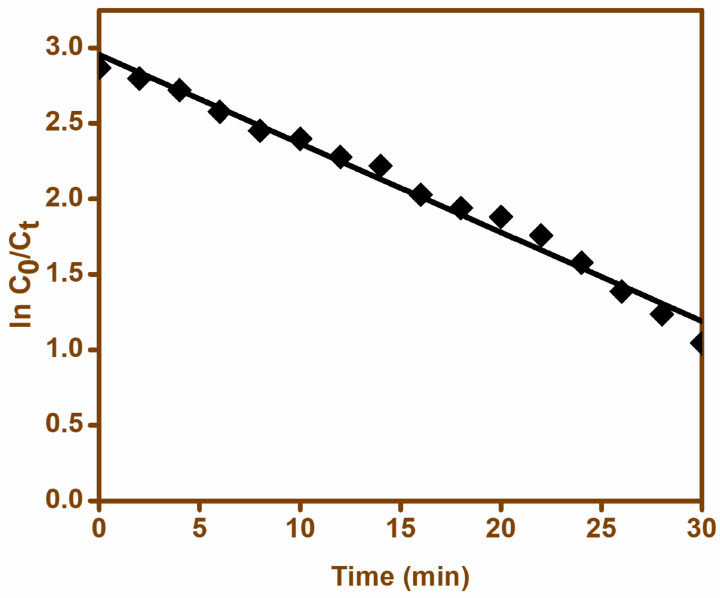
Figure 15. First-order kinetics model for cefixime degradation by BFO-M